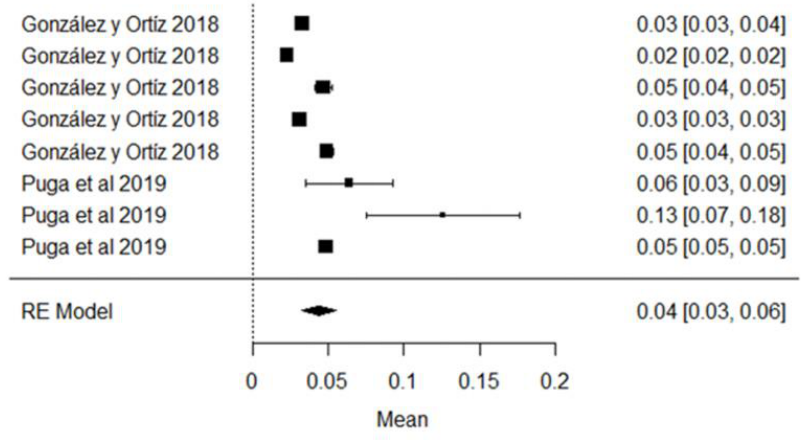
Figure 15. AFM1 forest plot [40,81].